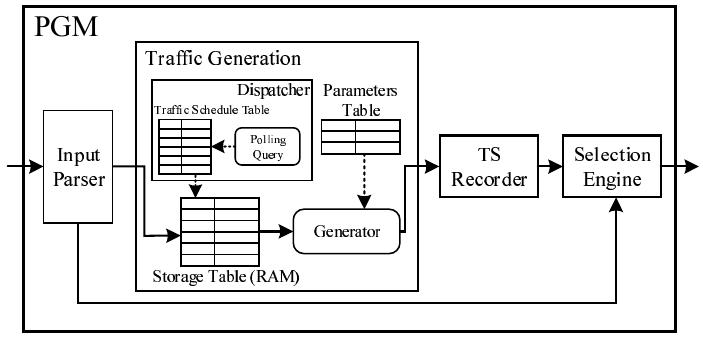
Figure 5. The design of Packet Generation Module.